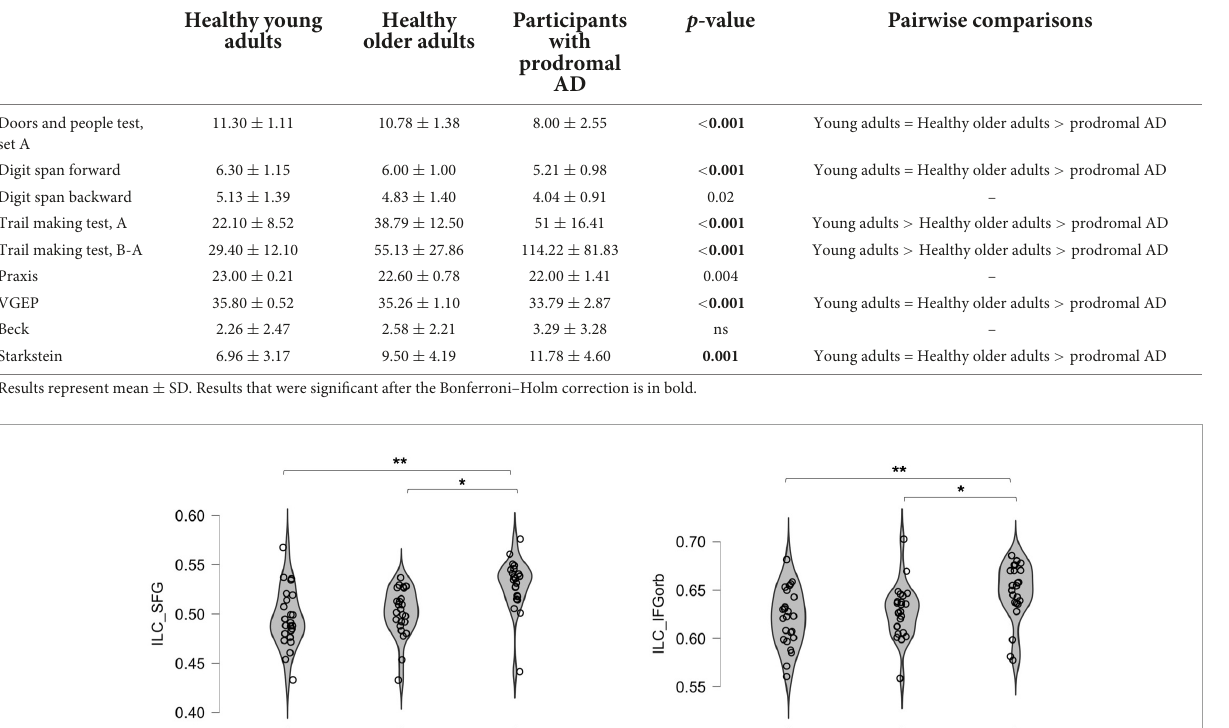
TABLE 3 Performance on the neuropsychological assessment (Kruskal–Wallis).